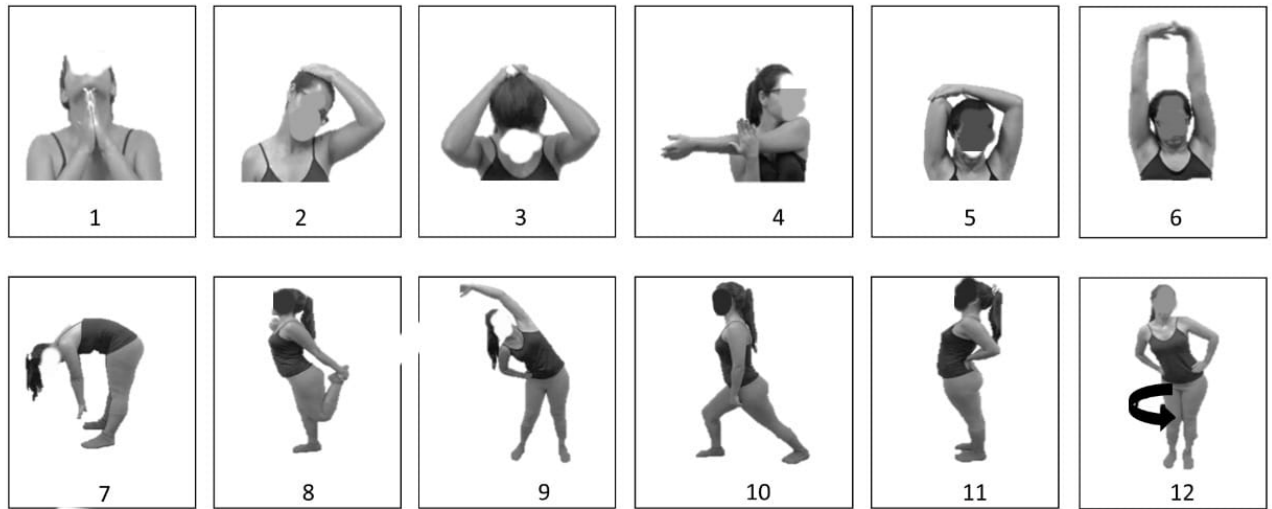
Figure 1. Stretching protocol. ( 1 ). Head extension; ( 2 ). Head lateroflexion; ( 3 ). Head flexion; ( 4 ). Shoulders; ( 5 ). Triceps; ( 6 ). Arm stretch; ( 7 ). Hamstrings; ( 8 ). Quadriceps; ( 9 ). Trunk lateroflexion; ( 10 ). Gastrocnemius; ( 11 ). Trunk extension; ( 12 ). Hip circle.